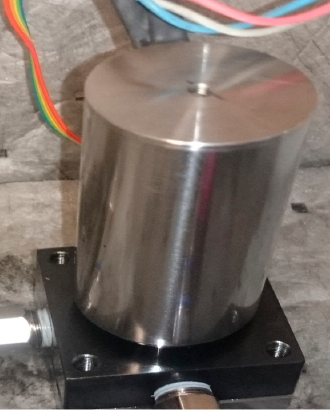
Figure 9. Pump embodiment of the mTGp prototype.